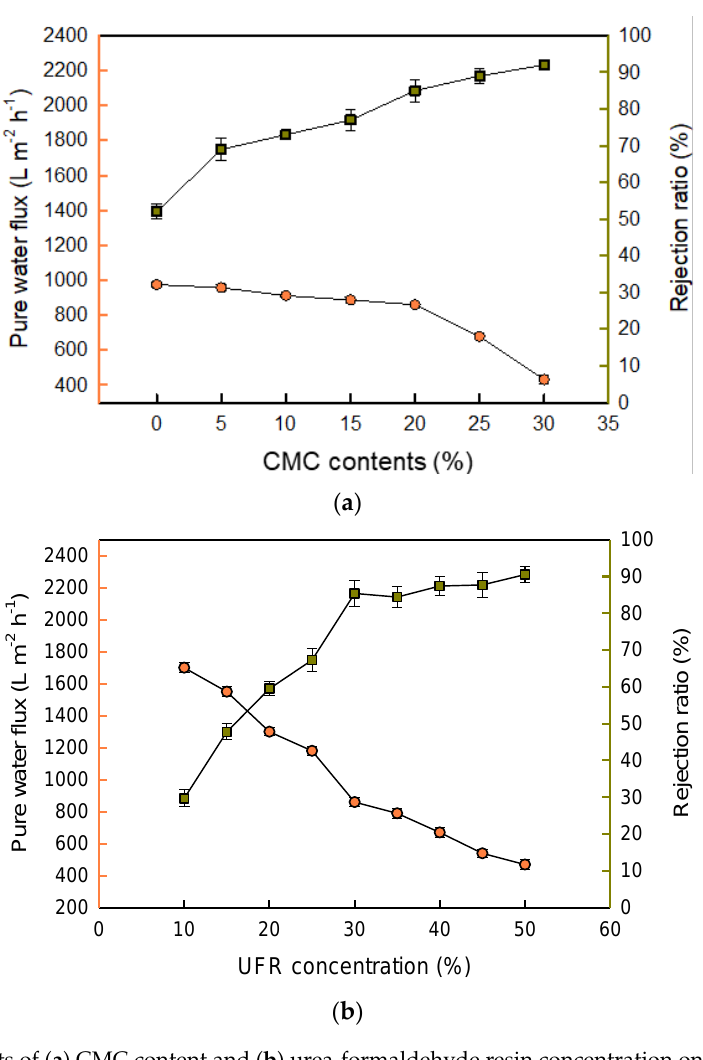
Figure 2. Effects of ( a ) CMC content and ( b ) urea-formaldehyde resin concentration on the pure water flux and rejection ratio of the composite membrane.